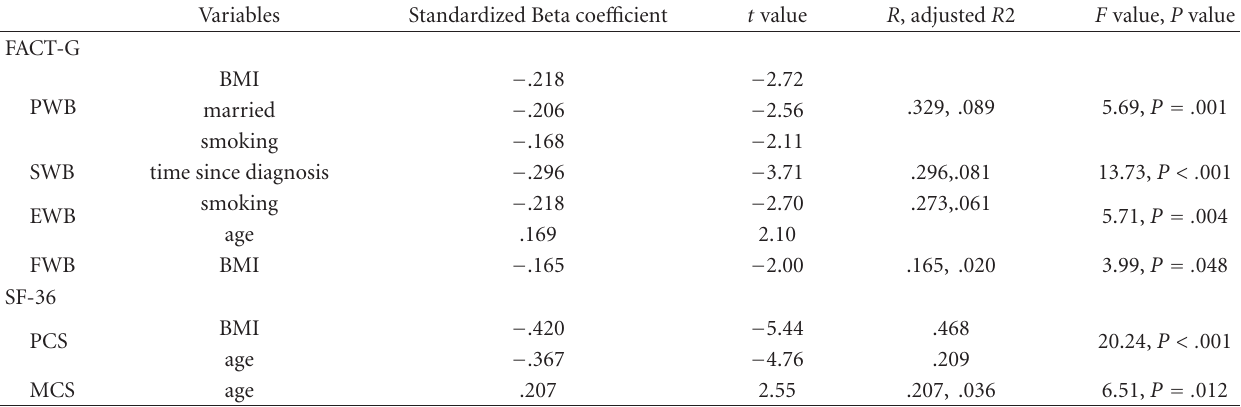
Table 4: Multiple linear regression analysis for each FACT-G domain and SF-36 PCS and MCS